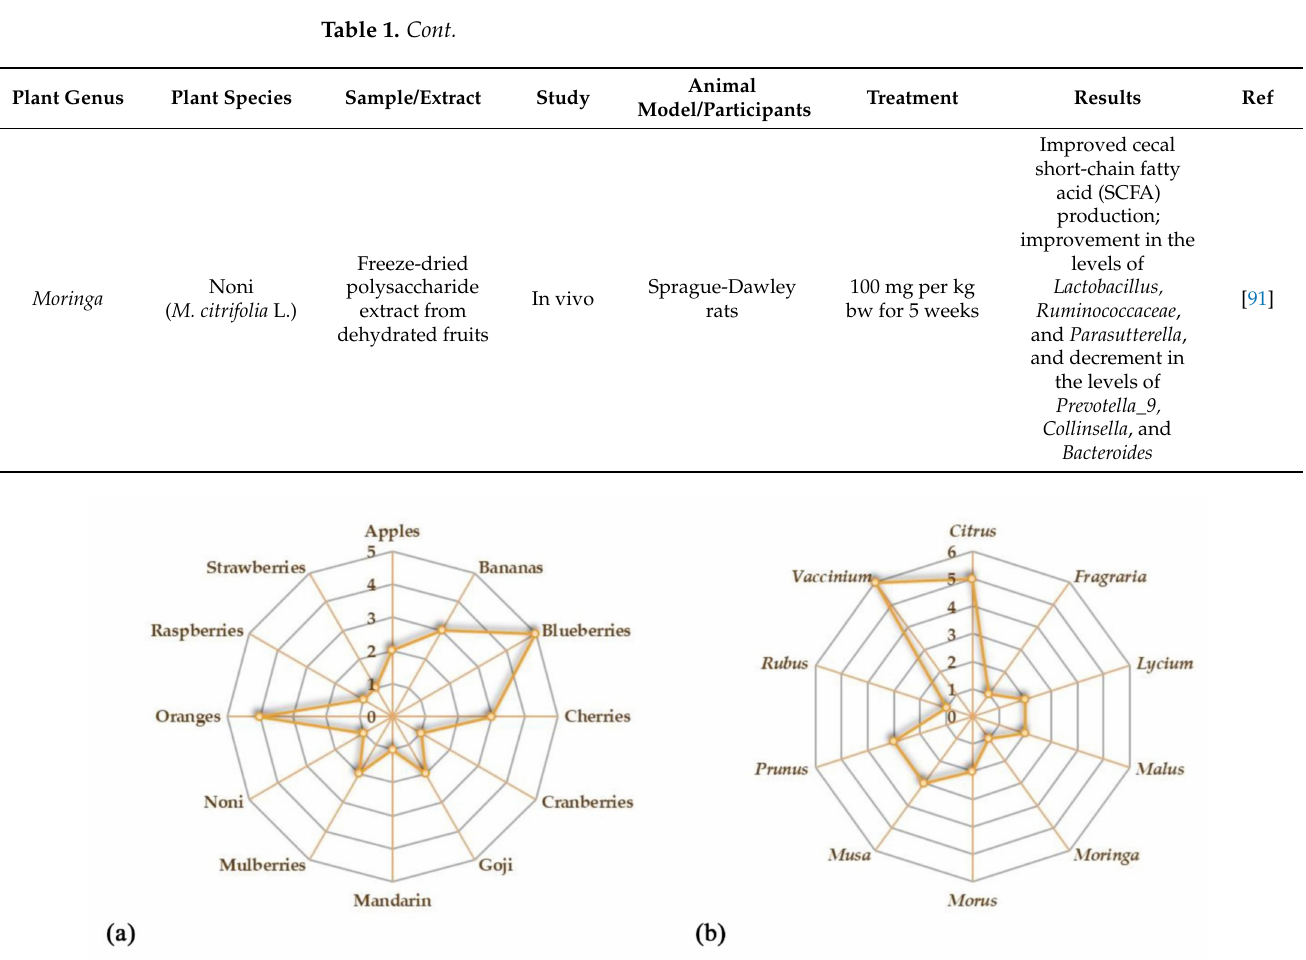
Figure 2. Kiviat diagrams visualizing the number of studies focusing on the beneficial effects of fruits ( a ) and plant genera ( b ) on gut